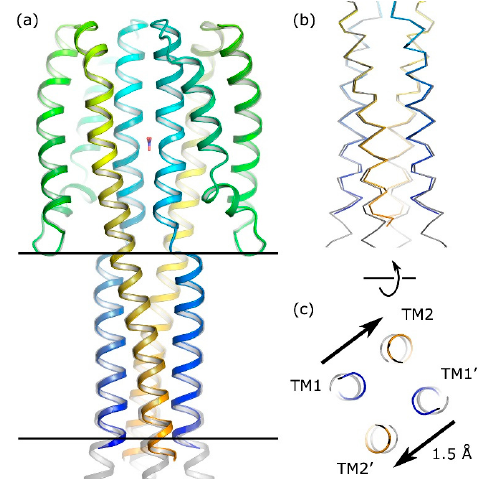
Figure 2. Differences in the transmembrane (TM) domain structures of the sensor–TM (rainbow coloring) and sensor–TM–HAMP (grey) constructs. ( a ) Overall comparison. Black lines show the approximate position of the membrane boundaries calculated using the PPM server [26]. ( b ) Comparison of the transmembrane regions. ( c ) Displacement of the cytoplasmic ends of the TM helices in the sensor–TM structure.